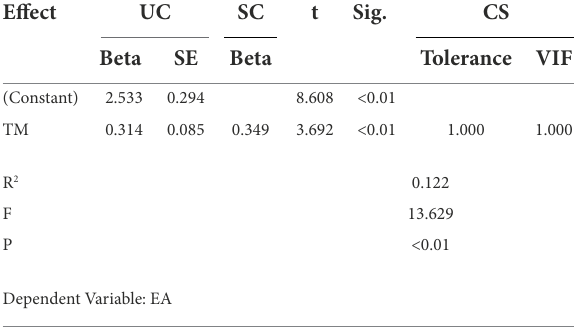
TABLE 5 Testing the effects of the predictors in the model on Emotions and attitudes.